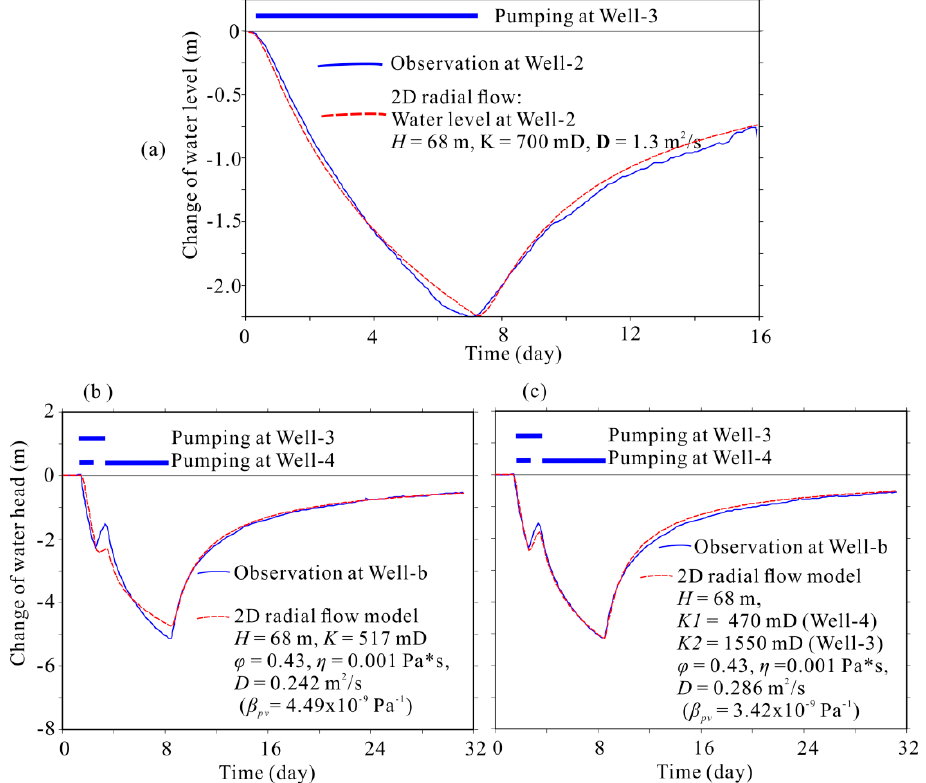
Figure 7. Water head changes estimated from the theoretical solution of a 2D radial flow in a homogeneous and isotropic infinite horizontal layer. (a ) Results of a single test. ( b ) Results of multiple tests in two wells, water head data were fitted by a single model. ( c ) Same to ( b ), but water head data were fitted by a combination of two single models to count the effect of spatial inhomogeneities. The observed data (dashed line) were represented very well by the theoretical solution with the optimal values of the permeability K of the layer and the compressibility β pv of the